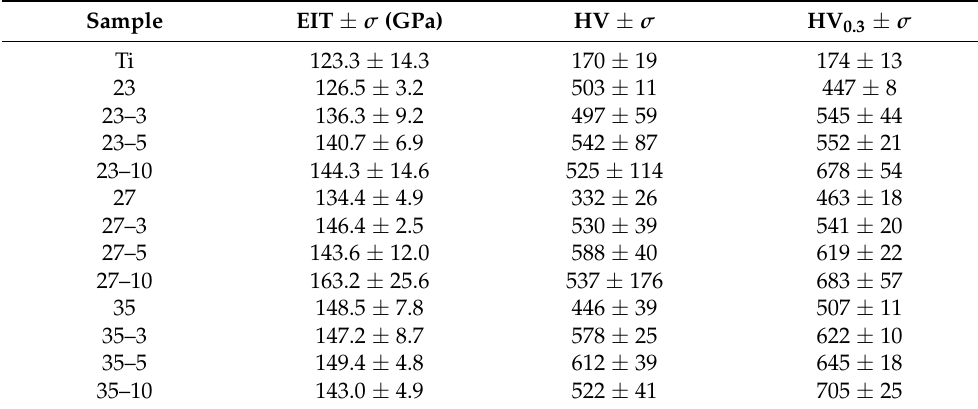
Table 3. Young’s modulus and hardness of Ti–Mo composites and pure titanium.